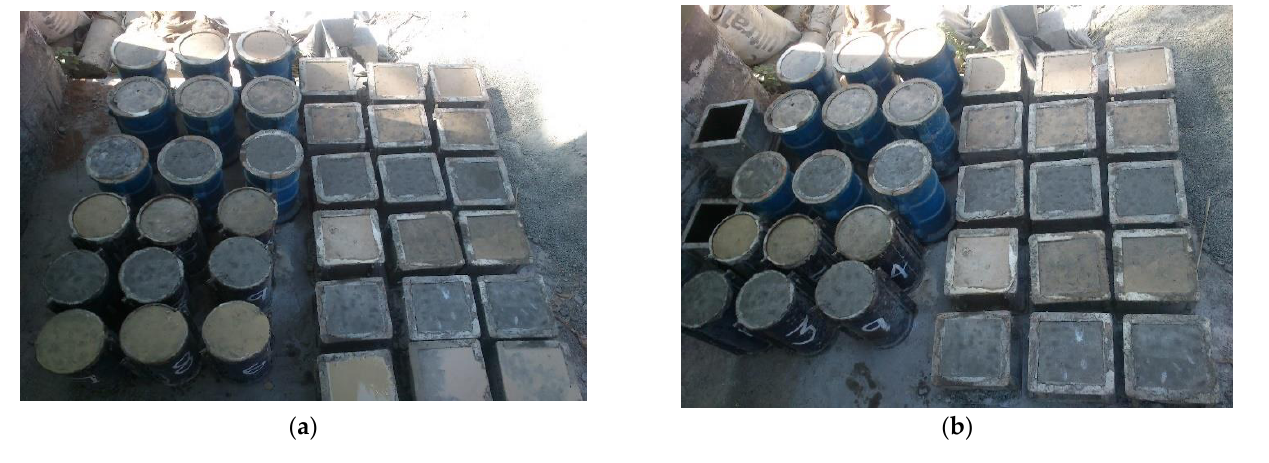
Figure 1. ( a ) GPC specimens, ( b ) CC specimens.